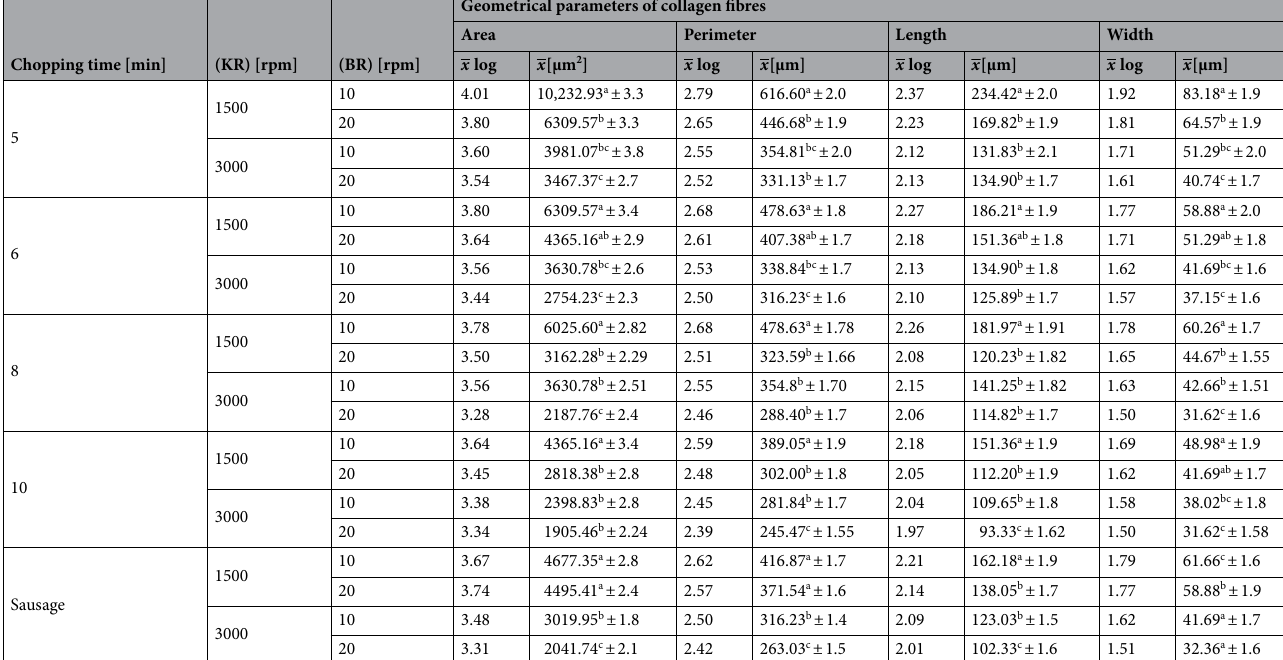
Table 7. The dimensions of collagen fibres versus the rotational speed of the cutter knives (KR) and bowl (BR) (1500/10, 1500/20, 3000/10 and 3000/20